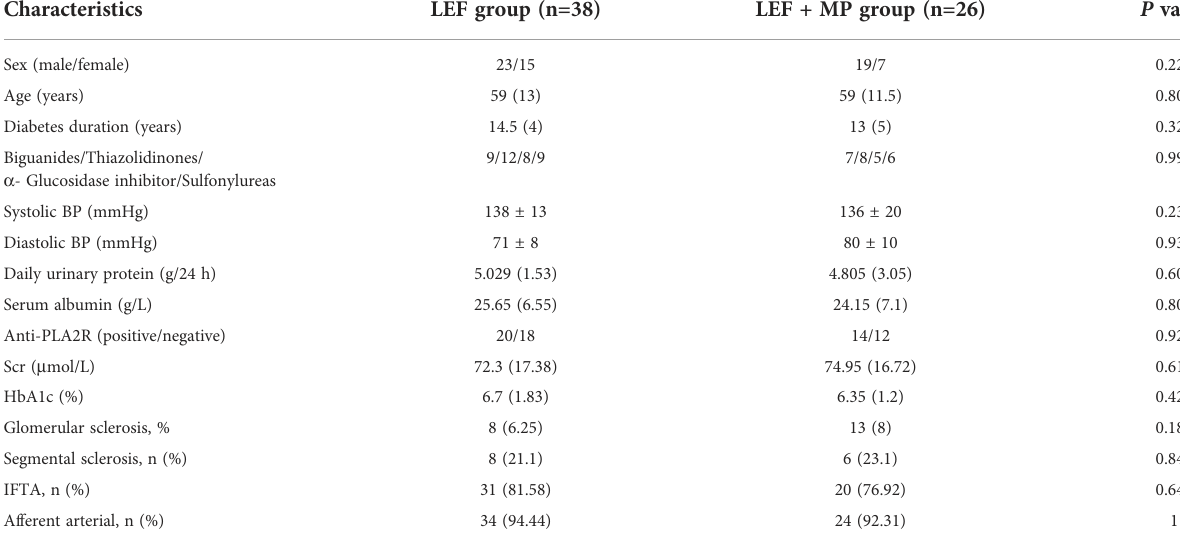
TABLE 1 Baseline characteristics of the patients in the two groups.